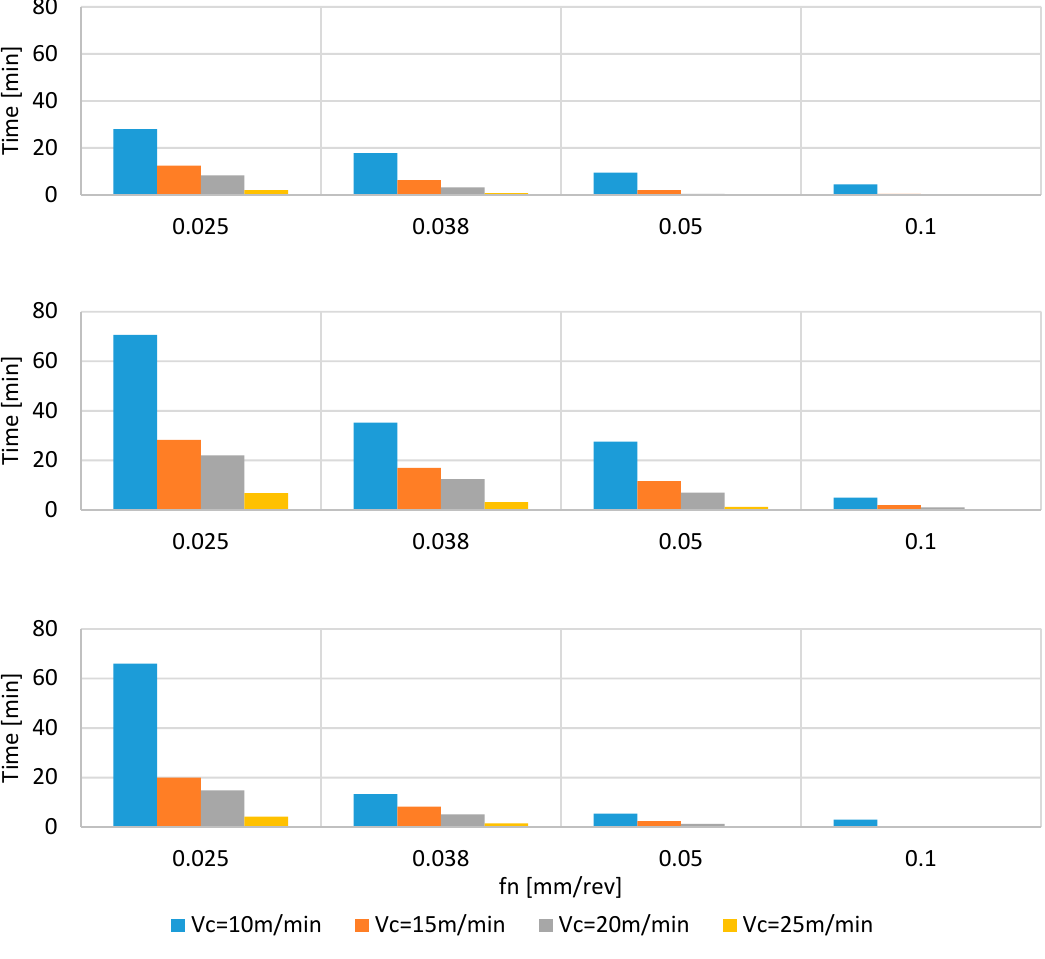
Figure 6. Tool life comparison for drilling of the TNB alloy (up), ingot MoCuSi alloy (middle) and extruded MoCuSi alloy (down).